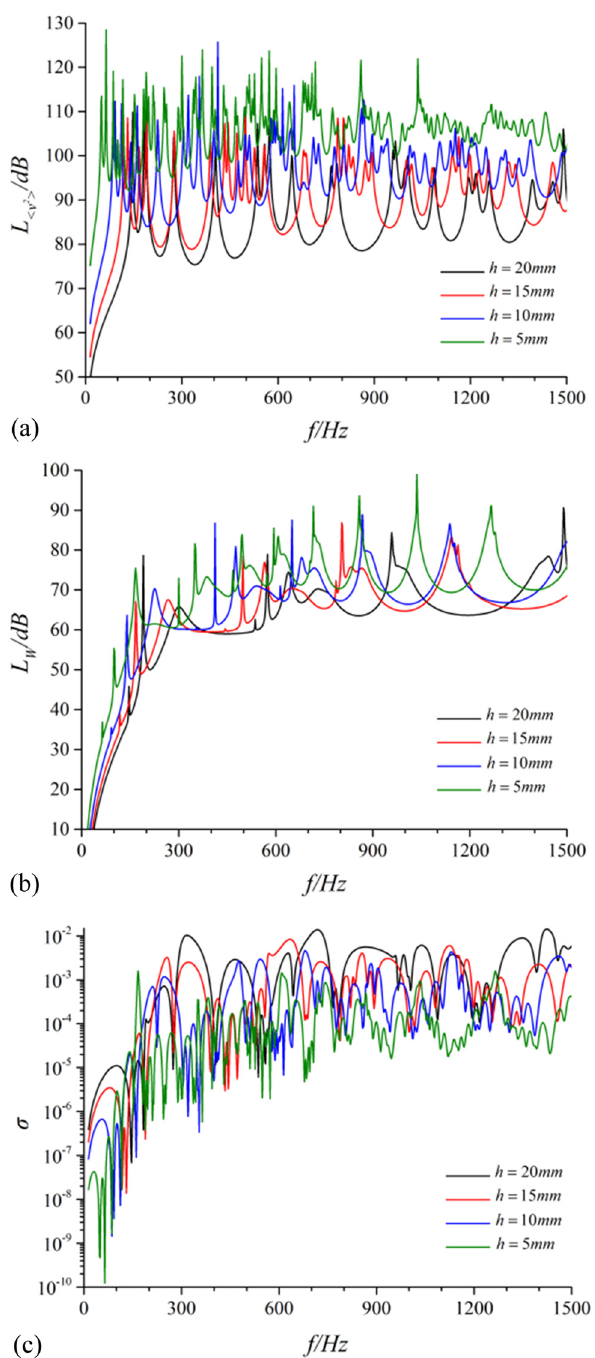
Figure 4: Contrast of vibration and noise performance for the cylindrical shell under di ff erent shell thicknesses. ( a ) Radial quad - ratic velocity level, ( b ) sound radiation power level, and ( c ) sound radiation e ffi